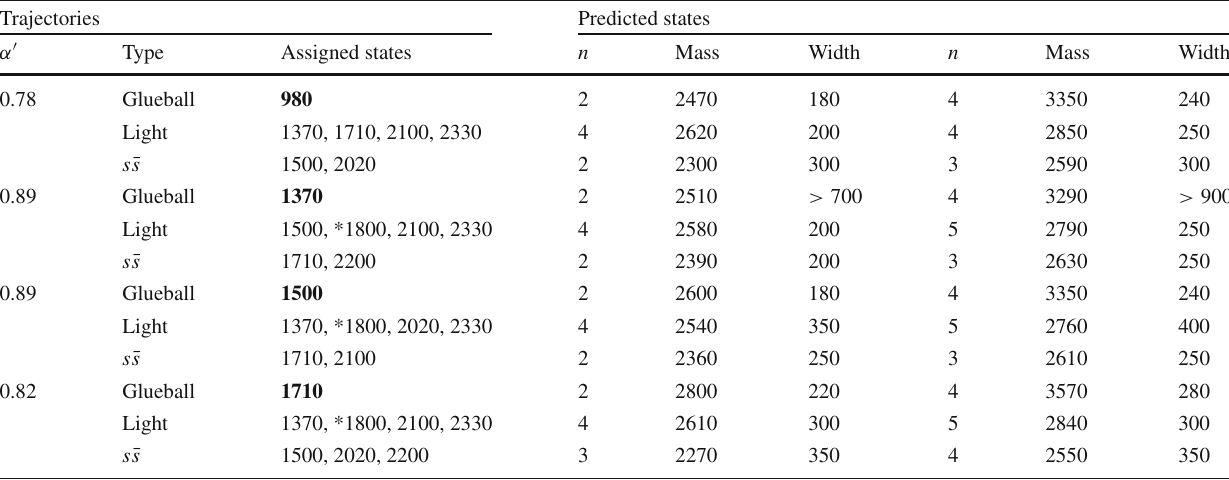
Table 5 The different assignments of the f 0 into radial trajectories and predicted higher states. The slope α (cid:2) (in units of GeV − 2 ) was fitted for each assignment separately, as was done in [4], but is common to all Trajectories Predicted